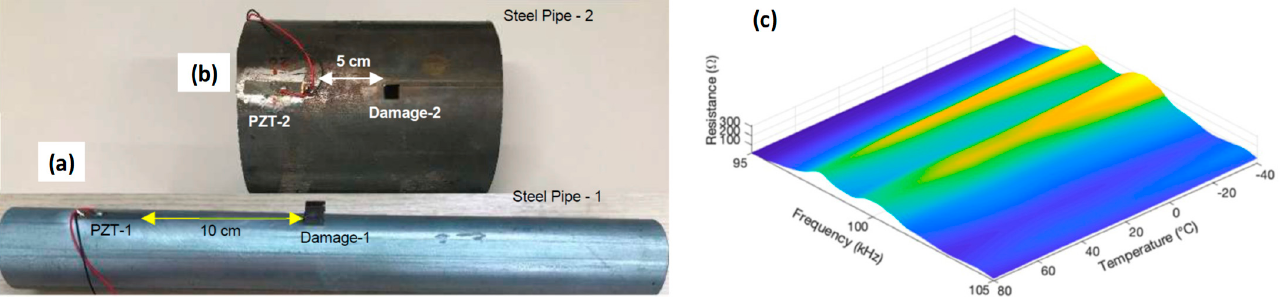
Figure 14. PZTs mounted on steel pipes: ( a ) pipe 1, ( b ) pipe 2, and ( c ) shifts in the impedance reso- nances in 95–105 kHz due to the temperature effect (adapted from [104]